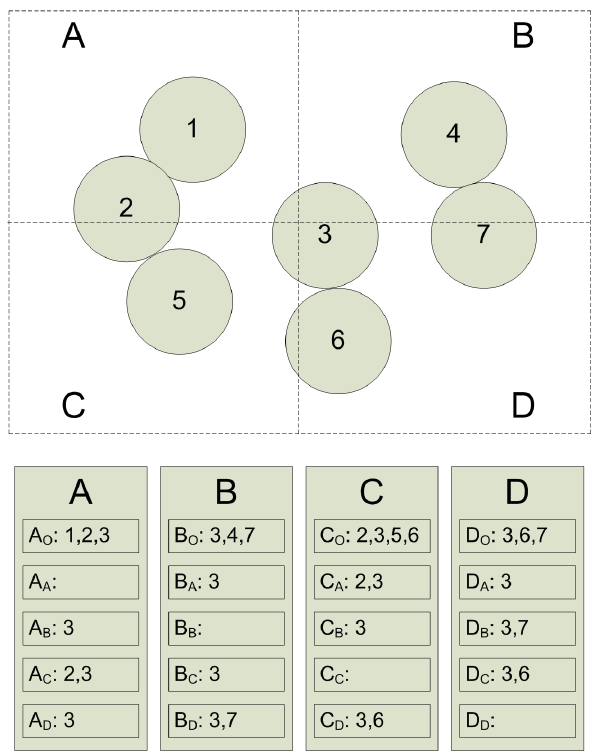
Figure 7 : (TOP) Sample 2D simulation domain with four sub- Figure 7. (Top) Sample 2-D simulation domain with four sub- domains and seven objects. (Bottom) Corresponding object lists for domains and seven objects. (BOTTOM) Corresponding object lists each for each sub-domain.